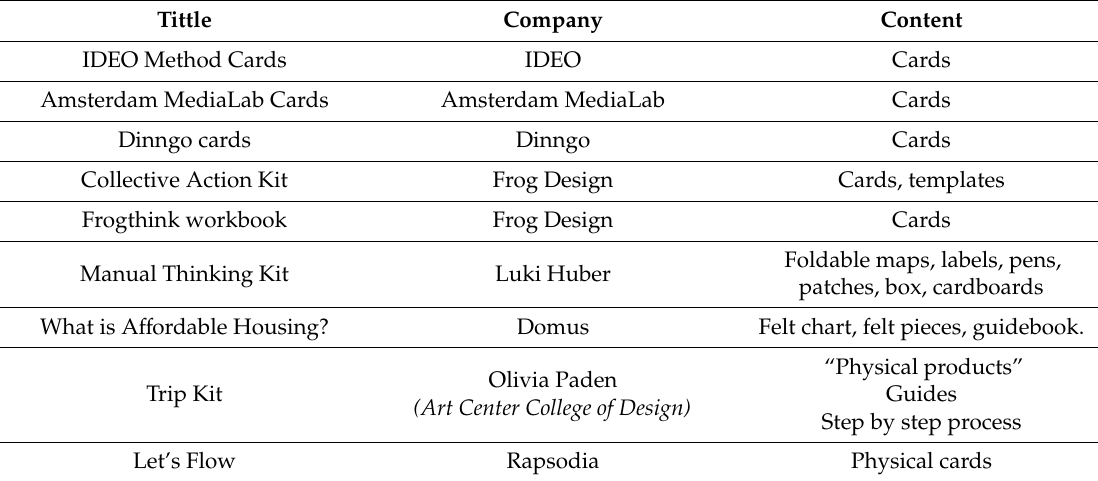
Table 2. Overview of existing design